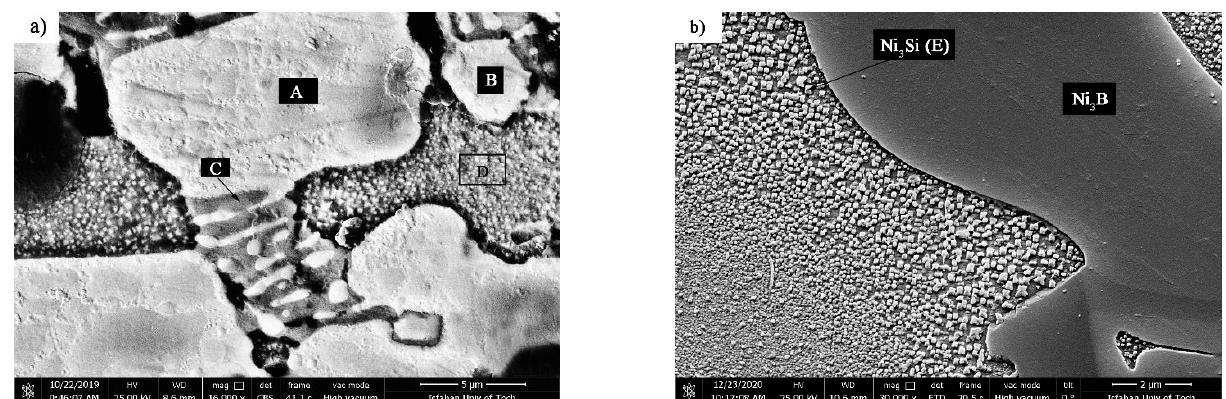
Figure 14. SEM microstructures of the TLP-bonded specimens with the 1010 ◦ C/10 min condition: ( a ) athermal solidification zone: (A) Ni 3 B, (B) Ni 3 B, (C) Ni 6 Si 2 B, (D) α -Ni and ( b ) solid-state precipitation of Ni 3 Si. Table 5. EDX analysis of various phases indicated in Figure 14 (wt. %).